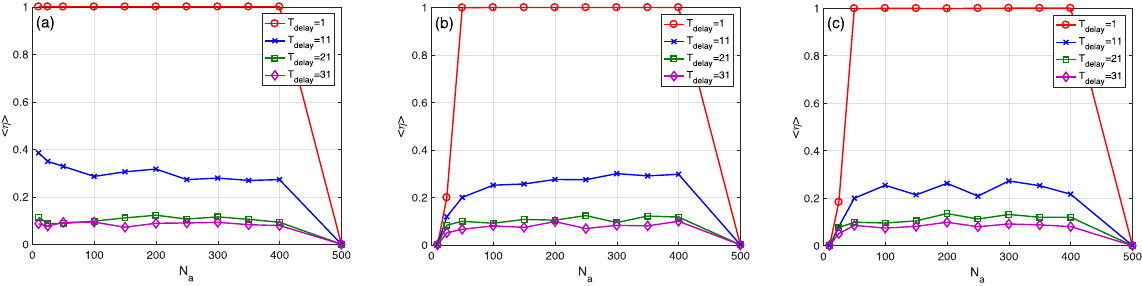
Figure 7. Balance between N a and k a for a fixed N a ⋅ k a . ( a ) Mean survival ratio 〈 η 〉 VS N a for the uniformly random selection with different T delay . ER networks. N = 1000, M = 1000, 〈 k 〉 = 20, k s = 11, q = 0.09, and f = 0.1. N a ⋅ k a = 5000. The threshold for determining a total collapse is d = 0.1. ( b ) Similar to (a) but for the roulette selection. ( c ) Similar to (a) but the anti-roulette selection.